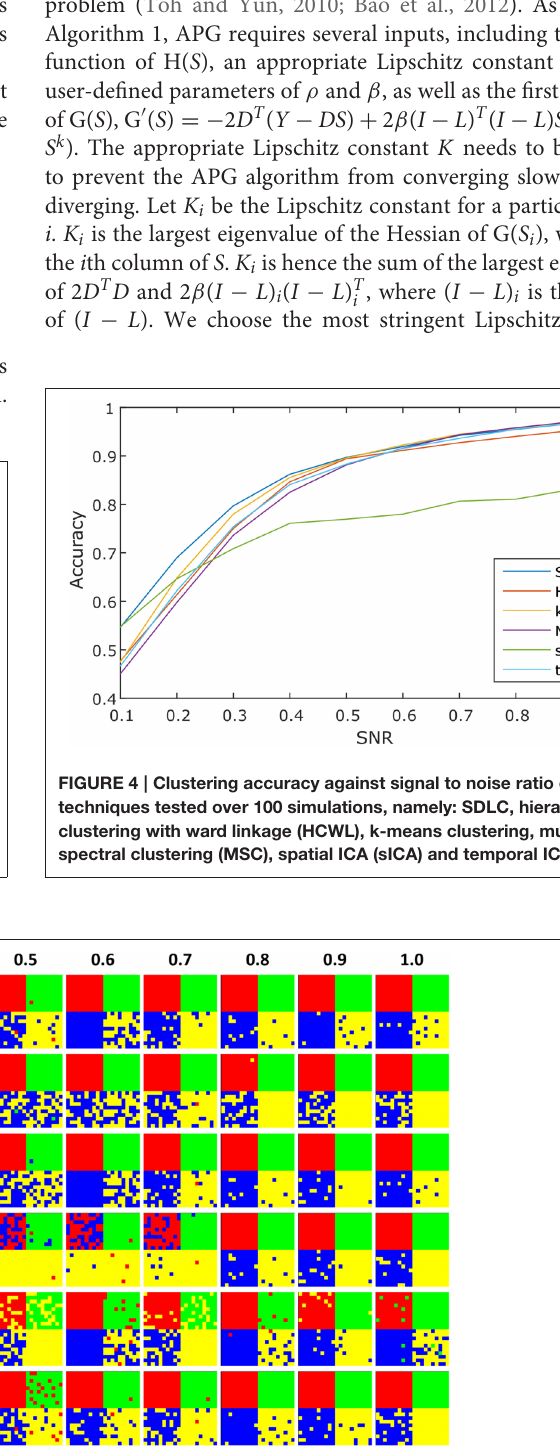
FIGURE 3 | Clustering results for the first simulation. Each row is the clustering results for each of the six techniques tested, namely: SDLC, hierarchical clustering with ward linkage (HCWL), k-means clustering, multi-class spectral clustering (MSC), spatial ICA (sICA) and temporal ICA (tICA). Signal to noise ratio of each column is labeled at the top of the figure. Columns from left to right have increasing signal to noise